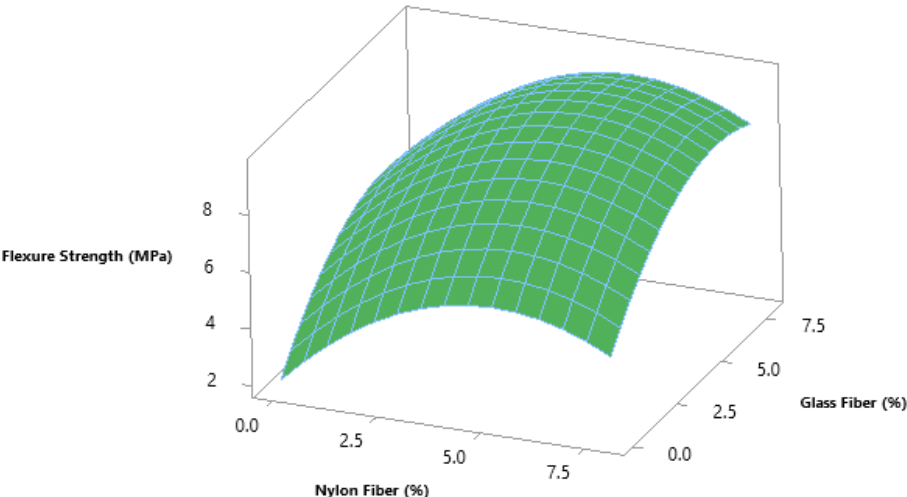
Figure 12. Three-dimensional response surface for flexural strength.